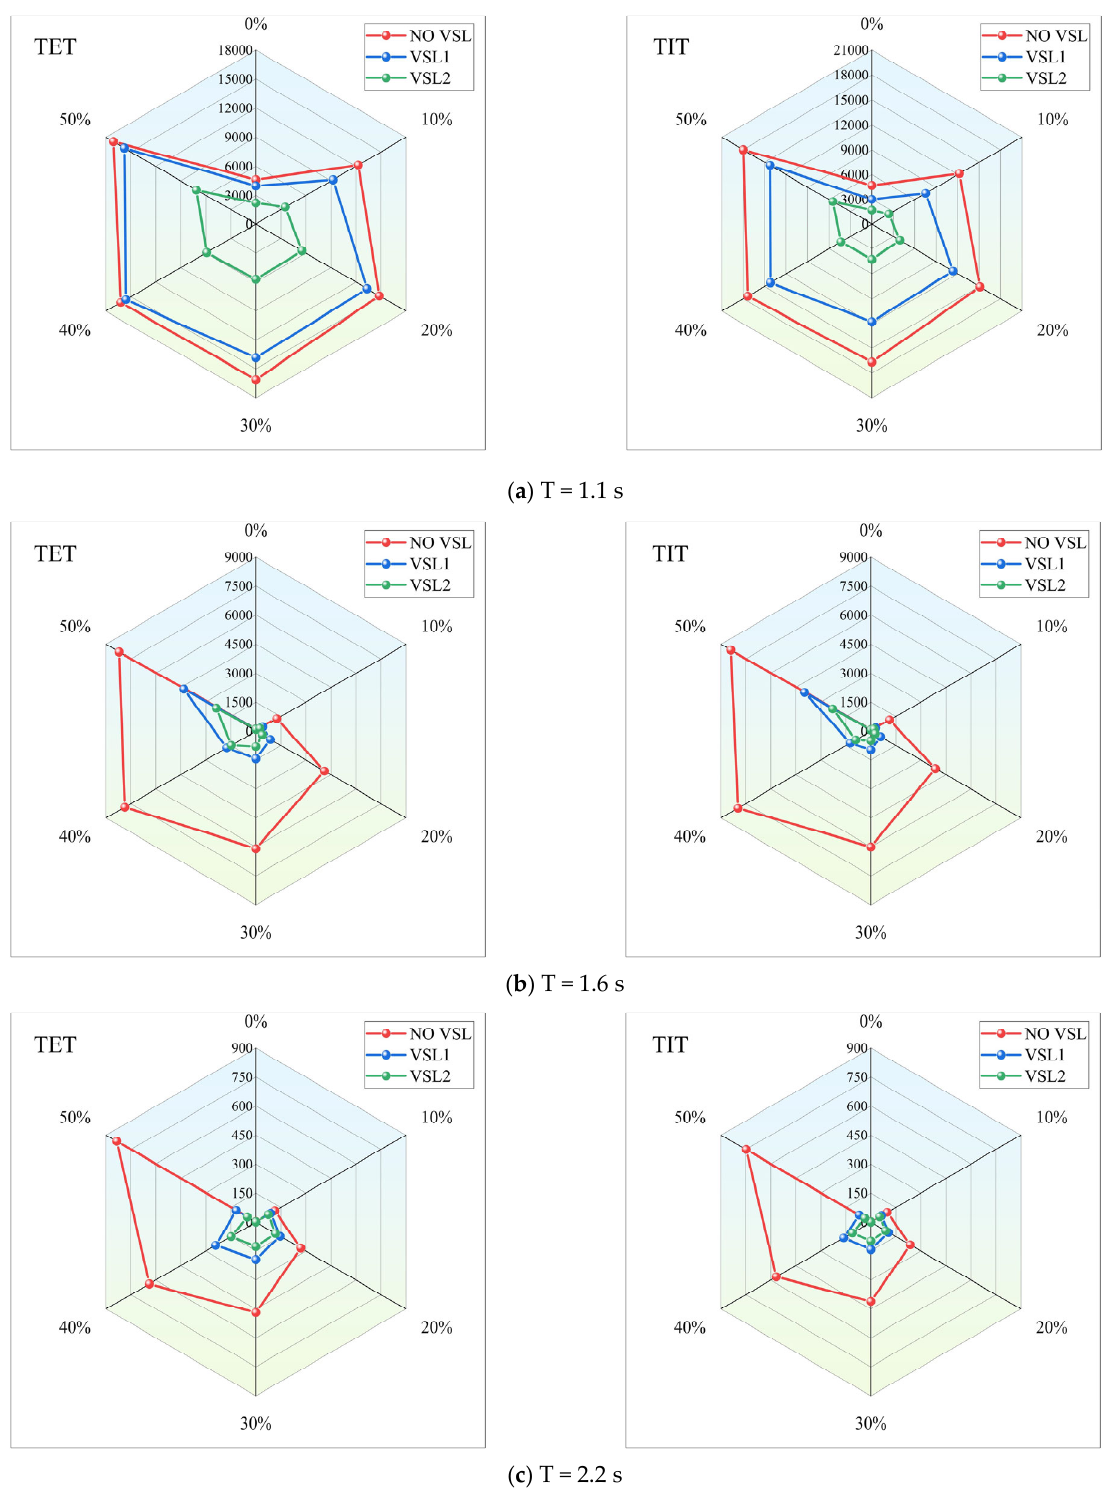
Figure 5. Safety results of VSL control strategies.